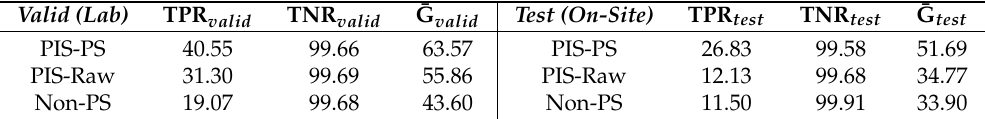
Table 1. Performance results for validation data ( left ) and test data ( right ). Note : Validation data is generated from the same sample objects as the training data and, like those, acquired in the lab. Test data is generated from different sample objects acquired on-site in the real inspection environment.